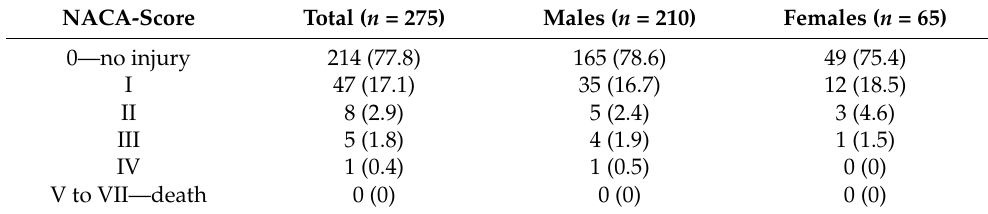
Table 2. Distribution of injury severity quantified by NACA-Score in the full sample and by